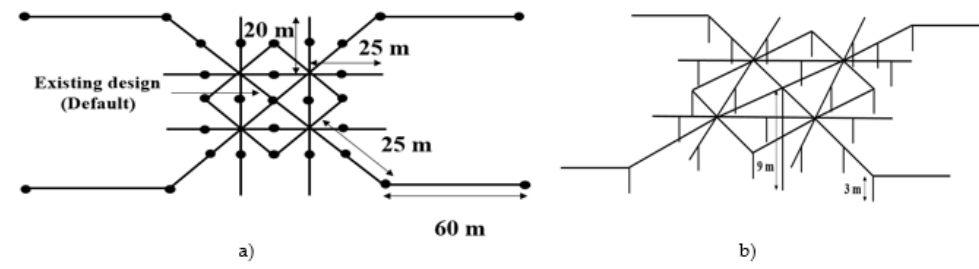
Figure 5. Design B: Radial and ring electrodes; ( a ) top view; ( b ) 3D view.